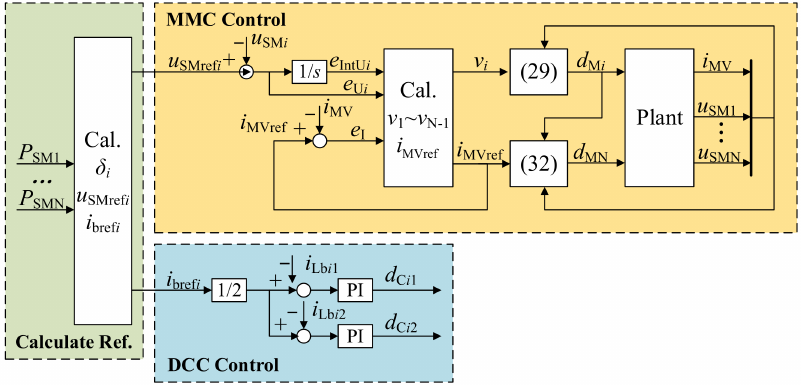
Figure 4. Block diagram of MMC-driven IVCS.